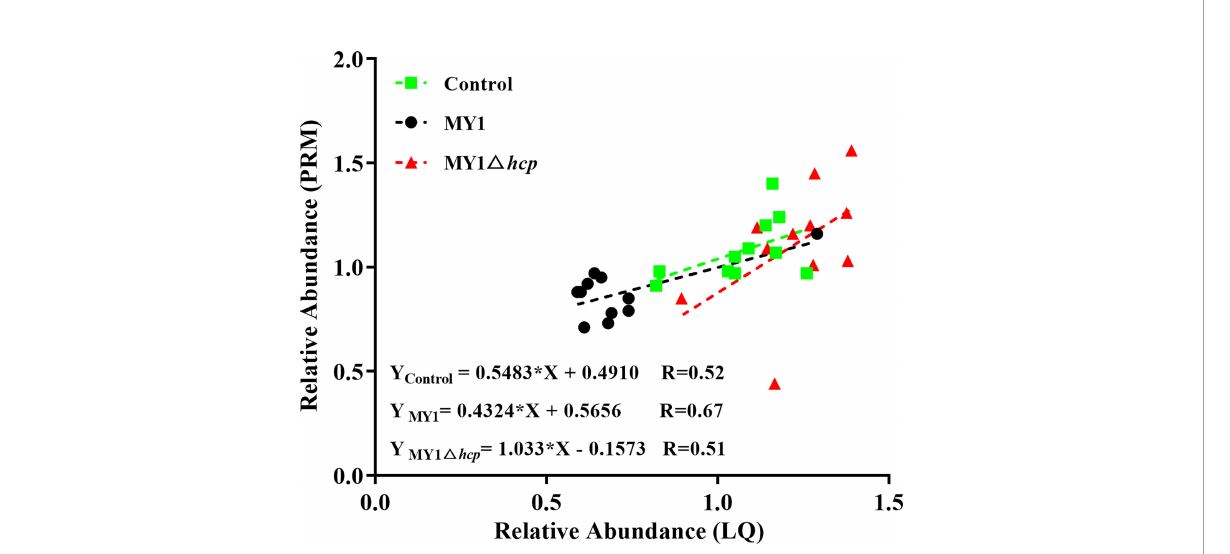
FIGURE 5 Linear regression fi tted for relative abundance of selected proteins determined via LQ and PRM. The selected proteins in samples were used for linear regression